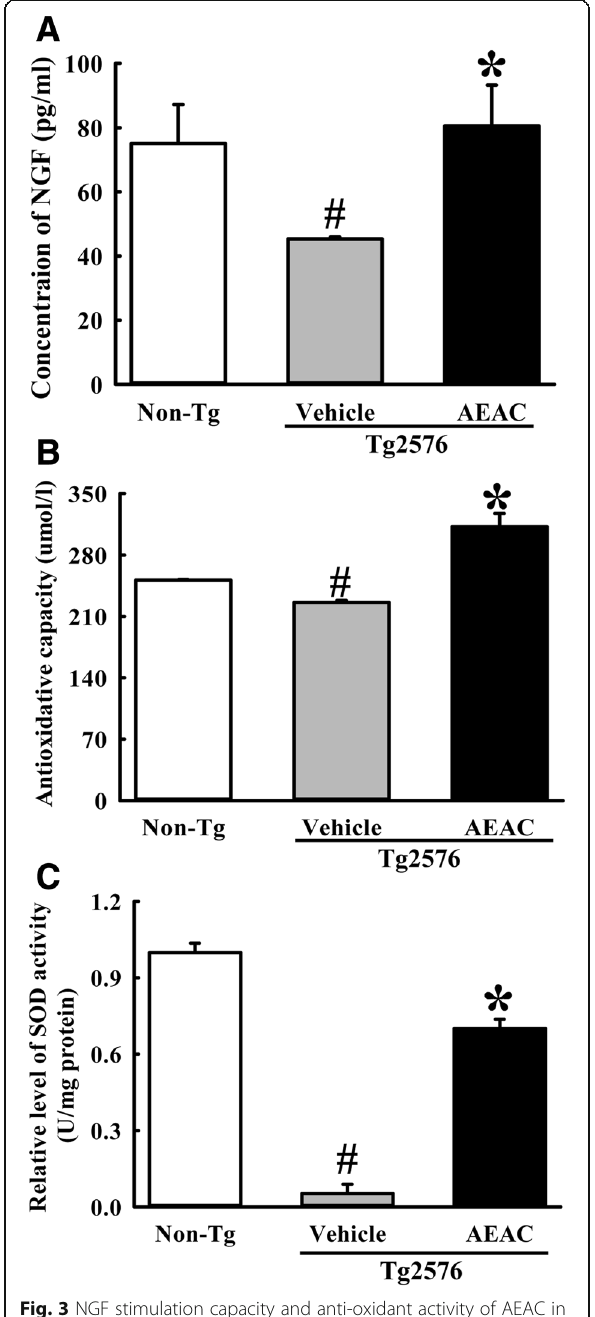
Fig. 3 NGF stimulation capacity and anti-oxidant activity of AEAC in Tg2576 mice. a Detection of NGF secretion in Tg2576 mice. NGF concentration was measured in serum of subset groups using an anti-NGF ELISA kit. b The anti-oxidant capacity was determined in serum collected from mice using a lipid peroxidation assay kit that could detect MDA at 0.1 nmole/mg to 20 nmole/mg. c SOD activity of the hippocampus collected from mice using an SOD assay kit. One unit of SOD is defined as the amount of enzyme in 20 μ l of sample solution that inhibits the reduction reaction of WST-1 with superoxide anion by 50%. Data represent the means ± SD of three replicates. # , p < 0.05 compared to the Non-Tg group; *, p < 0.05 compared to the Vehicle treated Tg2576